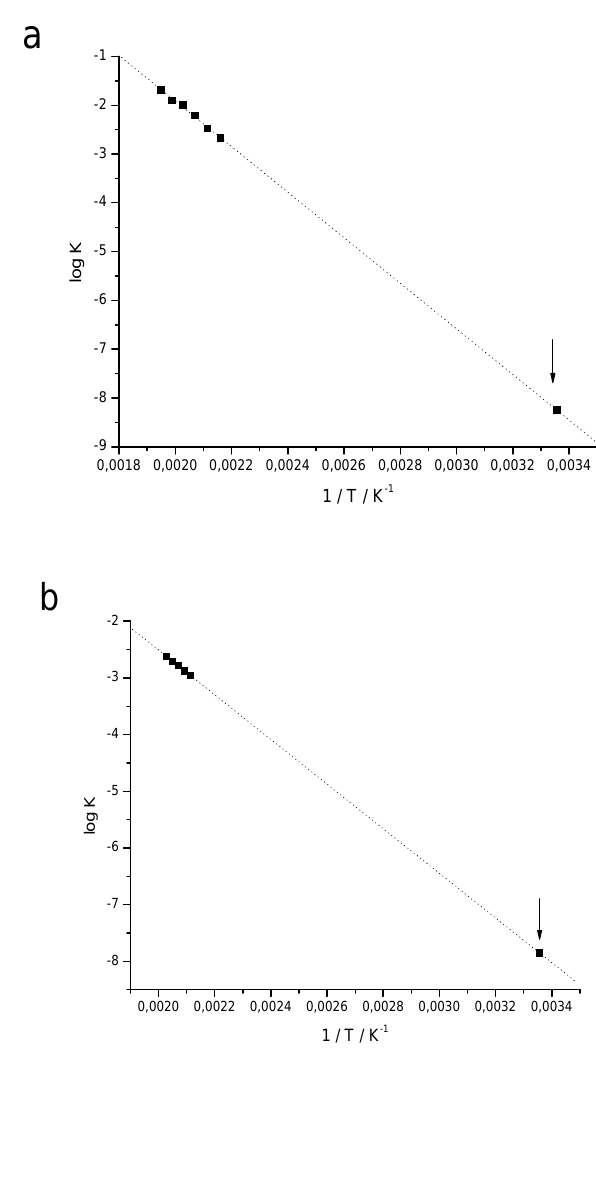
Figure 7. Graphic of the Arrhenius equation with values extrapolated to 25 °C for (a) verapamil hydrochloride, and for (b) pharmaceutical